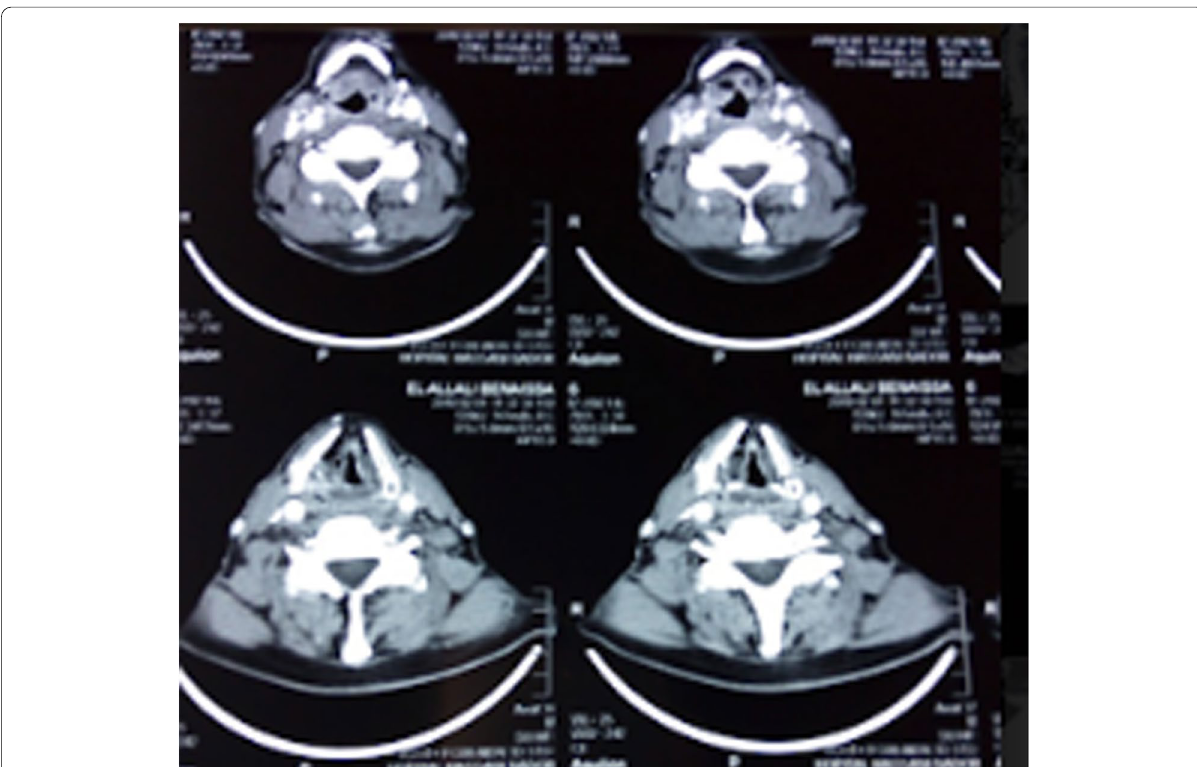
Fig. 2 Axial CT scan sections: thickening of laryngeal mucosa at the level of the thyroid cartilage and cricoid cartilage, with complete obstruction